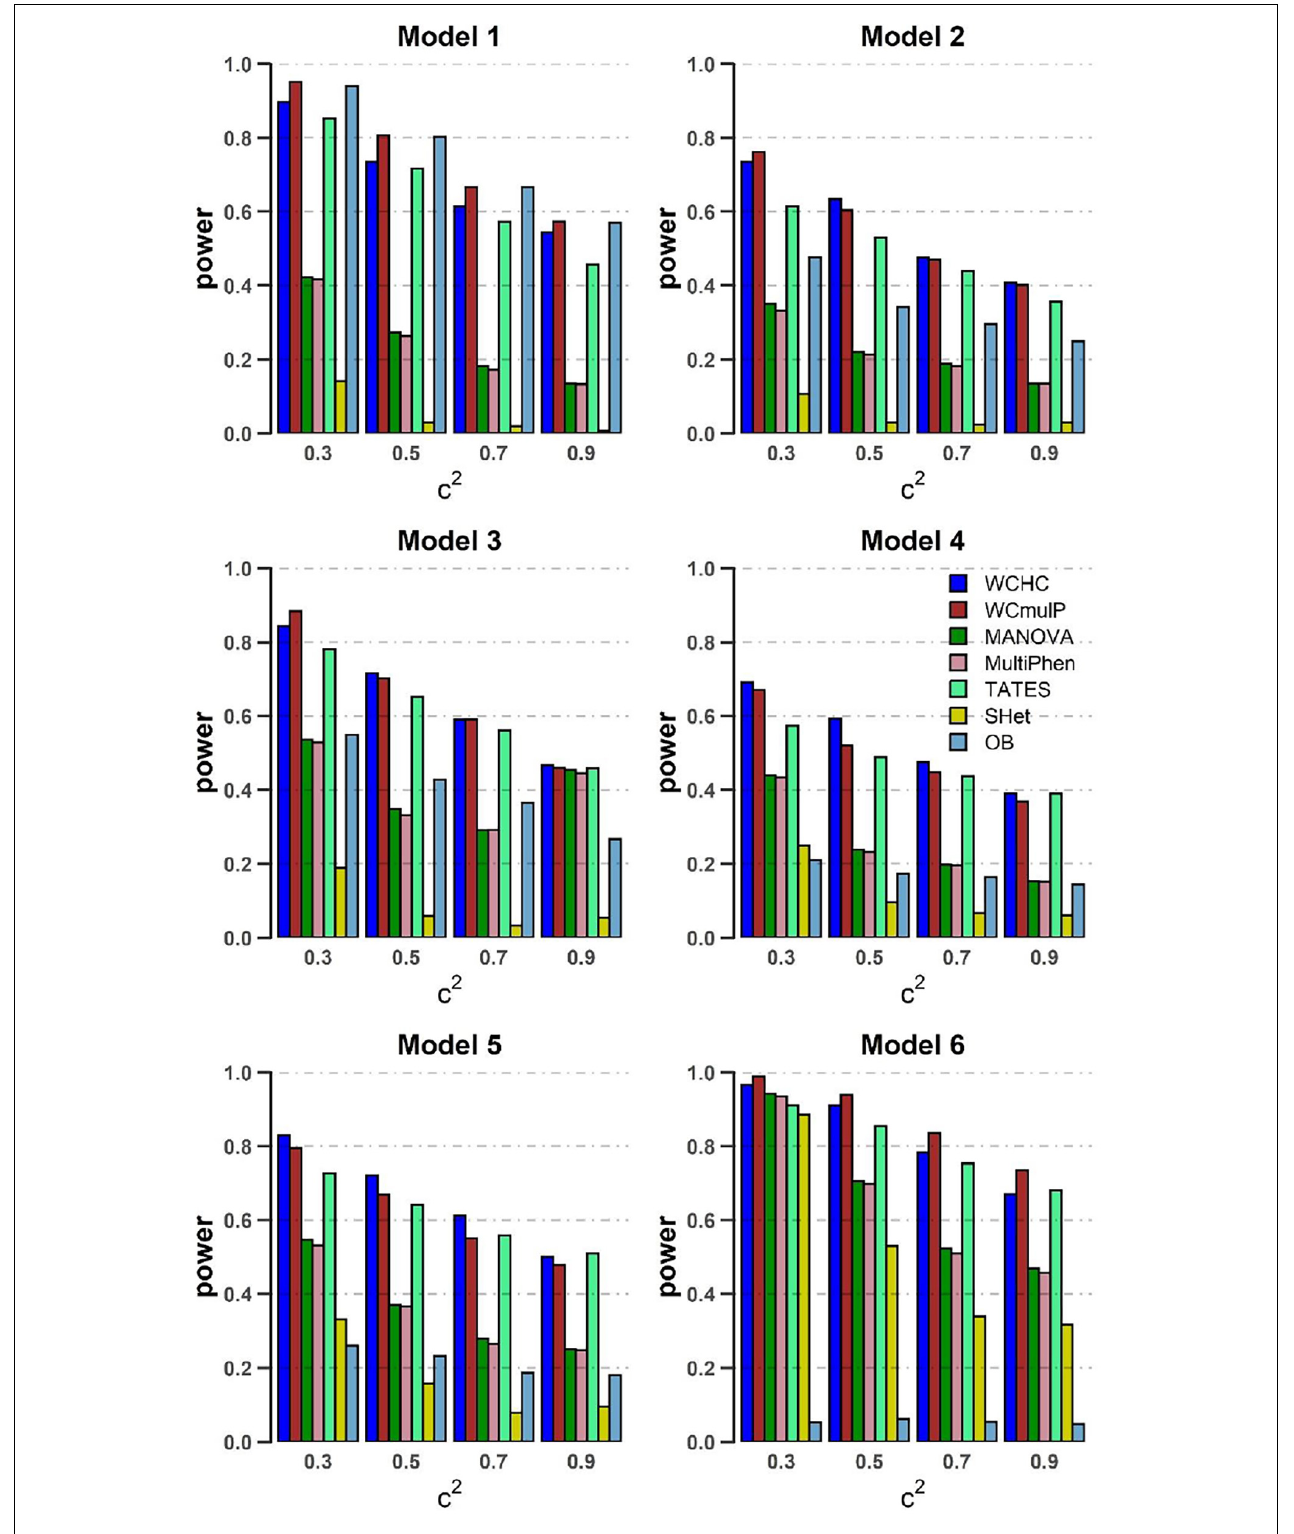
FIGURE 4 | Power comparisons of the seven methods as a function of c 2 in the six models. Sample size is N = 1,000, the number of phenotypes is M = 32, ρ c 2 = 0.1, and MAF = 0.3. β = 0.1 for model 1 and 4–6; β = 0.09 for model 2; β = 0.08 for model 3. The power of all the seven methods is estimated by 1000 replicated samples at a significance level of